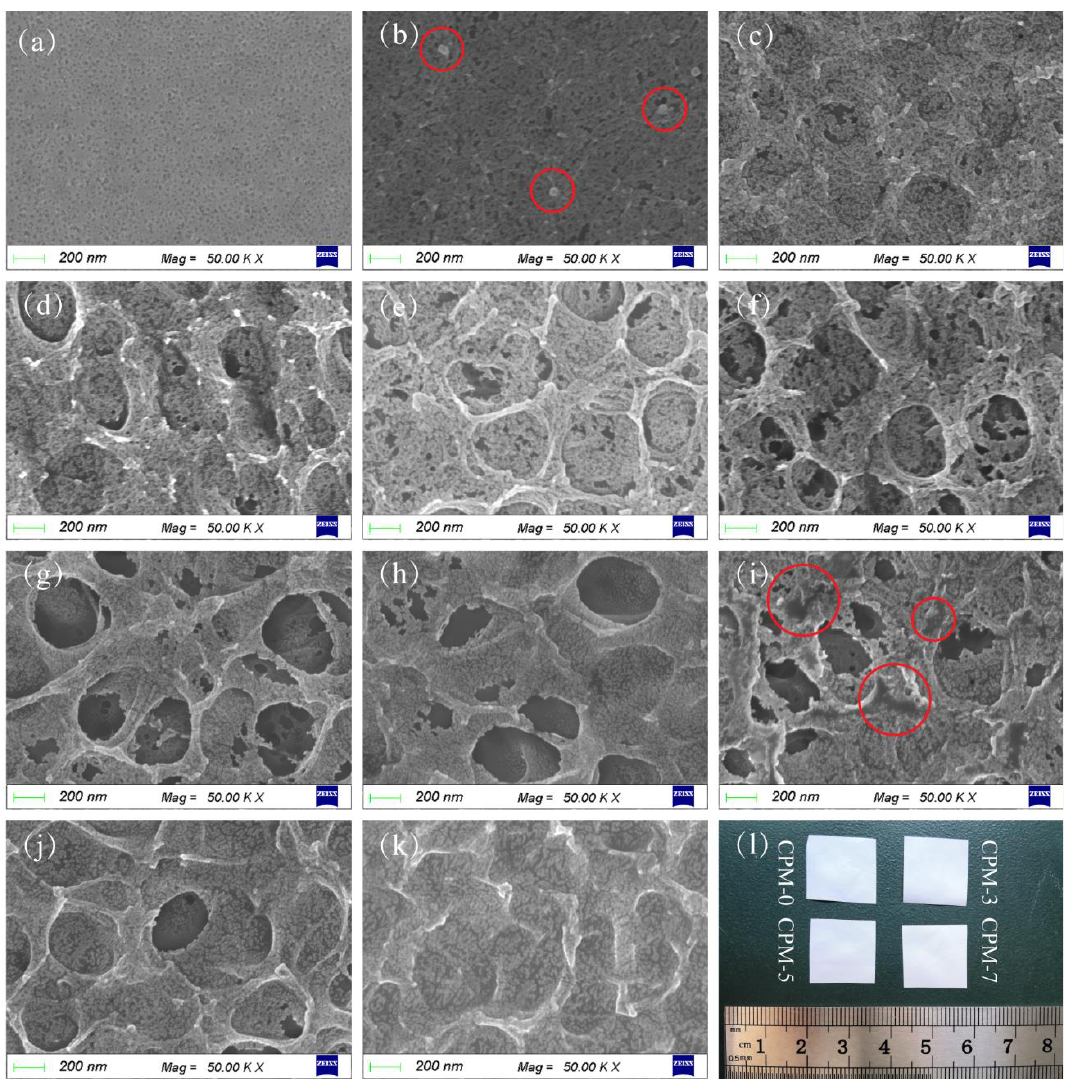
Figure 2. SEM micrographs of CPMs for surface in contact with air: ( a – k ) correspond to (CPM- 0~CPM-10), respectively; red circles in ( b ), dot-like structure; red circle in ( i ), dense non-porous structure; ( l ) photographs of CPM-0, CPM-3, CPM-5, and CPM-7.